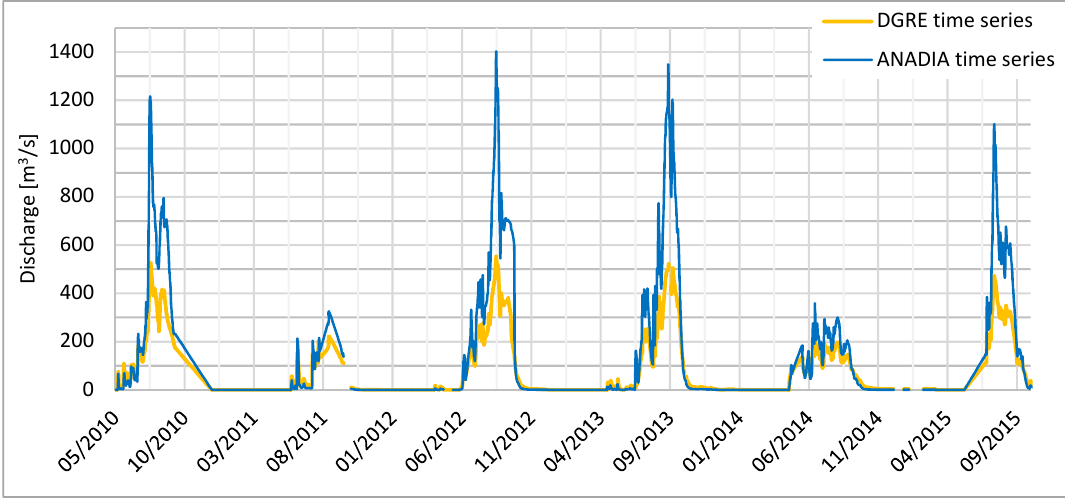
Figure 3. Hydrograph 2010–2015 at Garbey Kourou: DGRE (yellow line) and ANADIA (blue line) discharges.